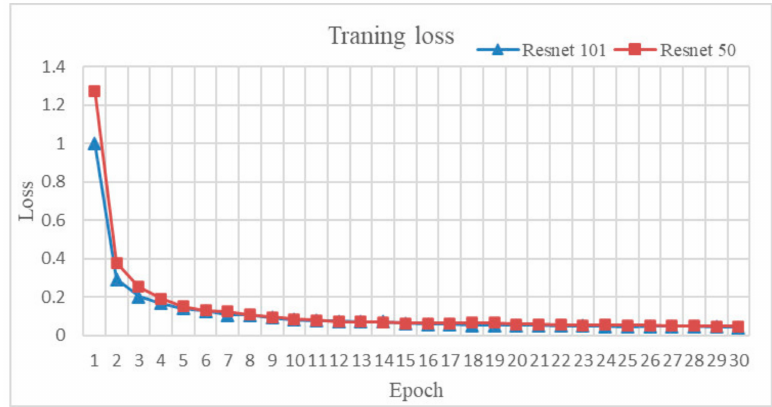
Figure 6. Training loss original network with Resnet 101 and Resnet